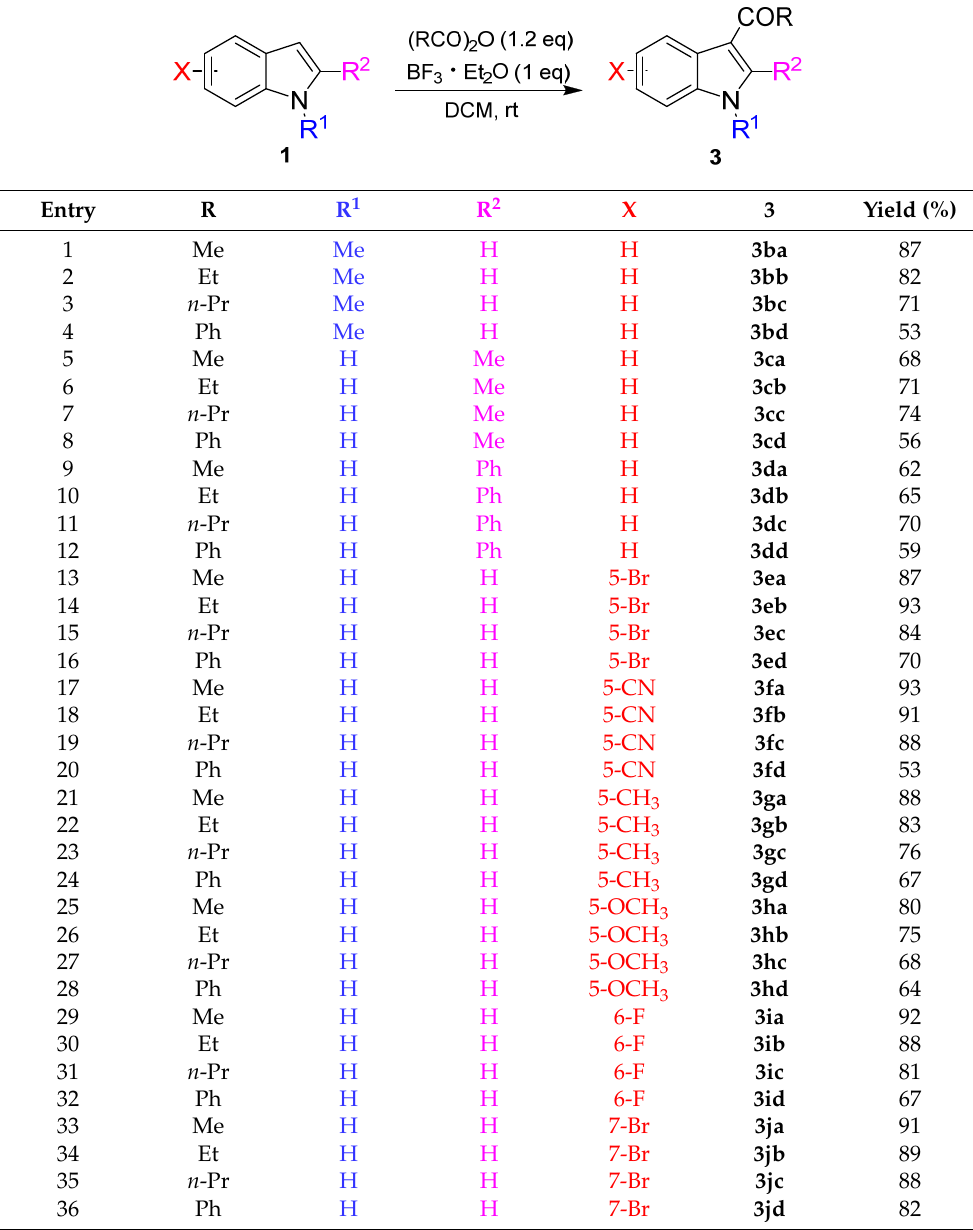
Table 3. Acylation of substituted indoles with anhydrides.